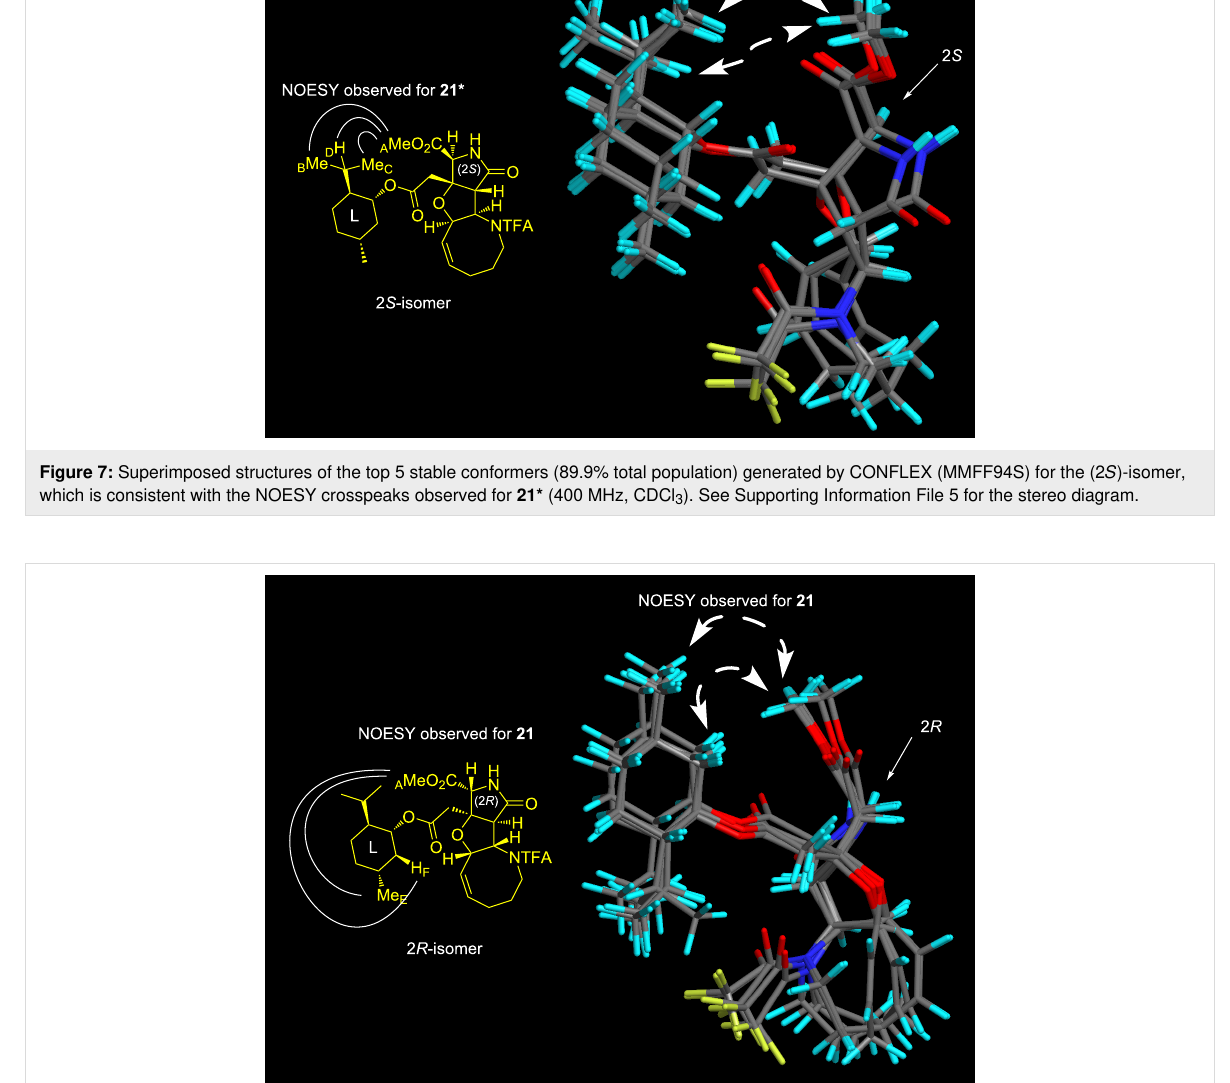
is 2 R , as described in Figure 6, Scheme 5, and Scheme 6.